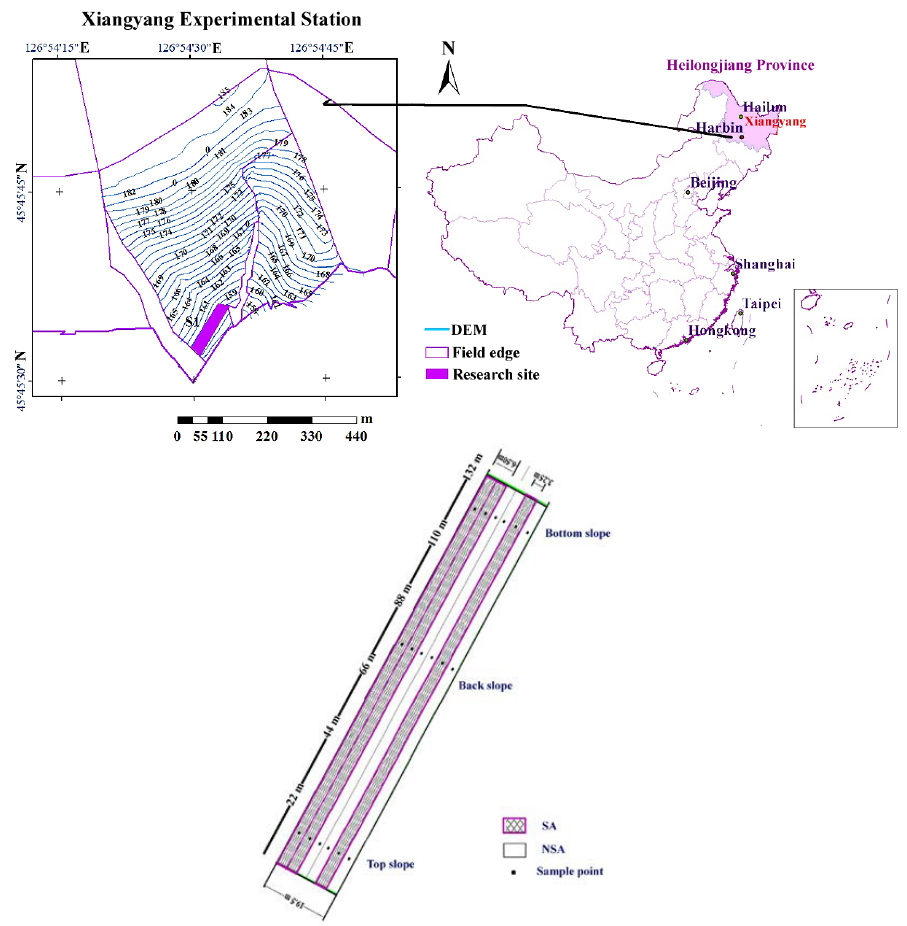
Figure 1. Location of the research area in China, and experimental plot design. Straw Amendment and No Straw Amendment are represented as SA and NSA, respectively.